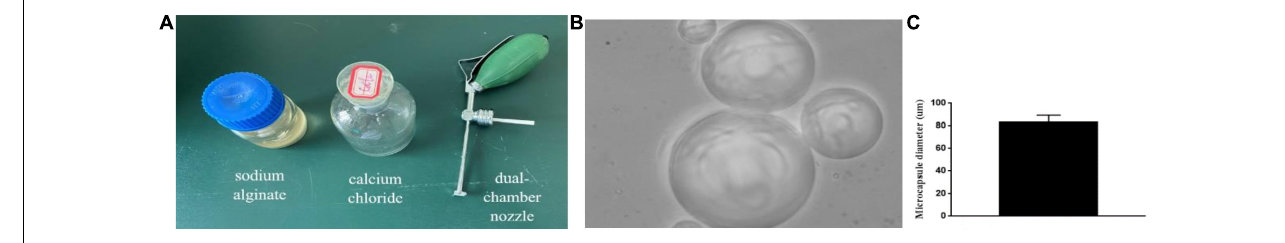
FIGURE 1 | Microencapsulation production: (A) Materials and equipment for making microcapsules. (B,C) × 400. The produced microcapsule picture and microcapsule diameter